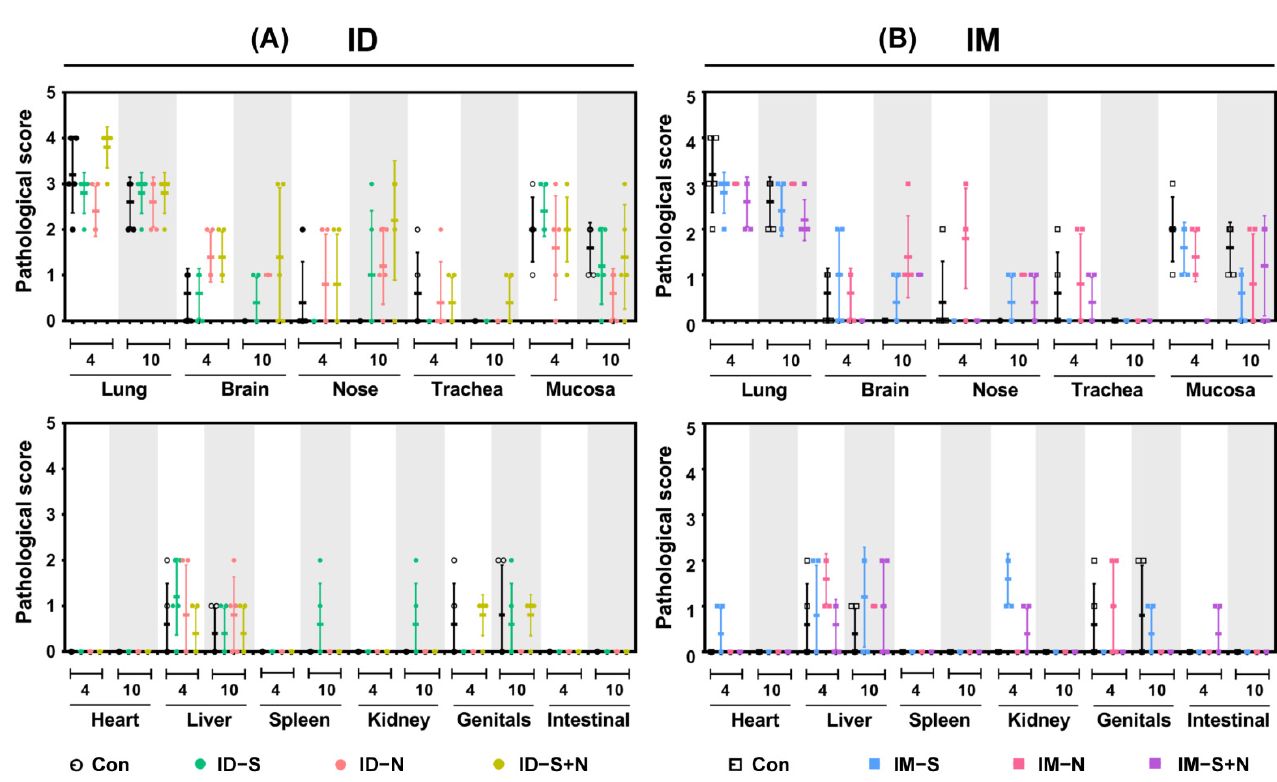
Figure 7. The pathological score of each tissue and organ from hamsters during viral challenge after immunization with the experimental vaccines via the ID and IM routes. ( A ) Challenge after ID and ( B ) challenge after IM. Scoring criteria: -, no abnormality (0); ±, slight infiltration of inflammatory cells (1); +, mild damage with inflammatory cell infiltration (2); ++, massive tissue damage with inflammatory cell infiltration and local vascular congestion (3); +++, serious tissue necrosis with inflammatory cell infiltrates and hyperemia (4); ++++, on the verge of death or dead (5).